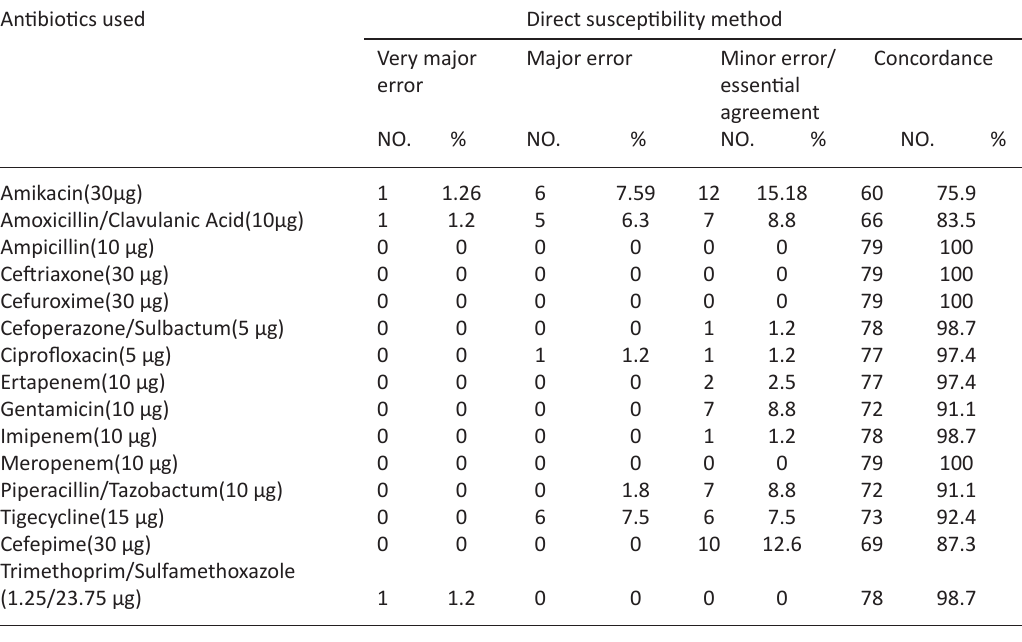
Table 3. Direct antibiotic susceptibility correlation for gram negative bacilli (n=79) Antibiotics